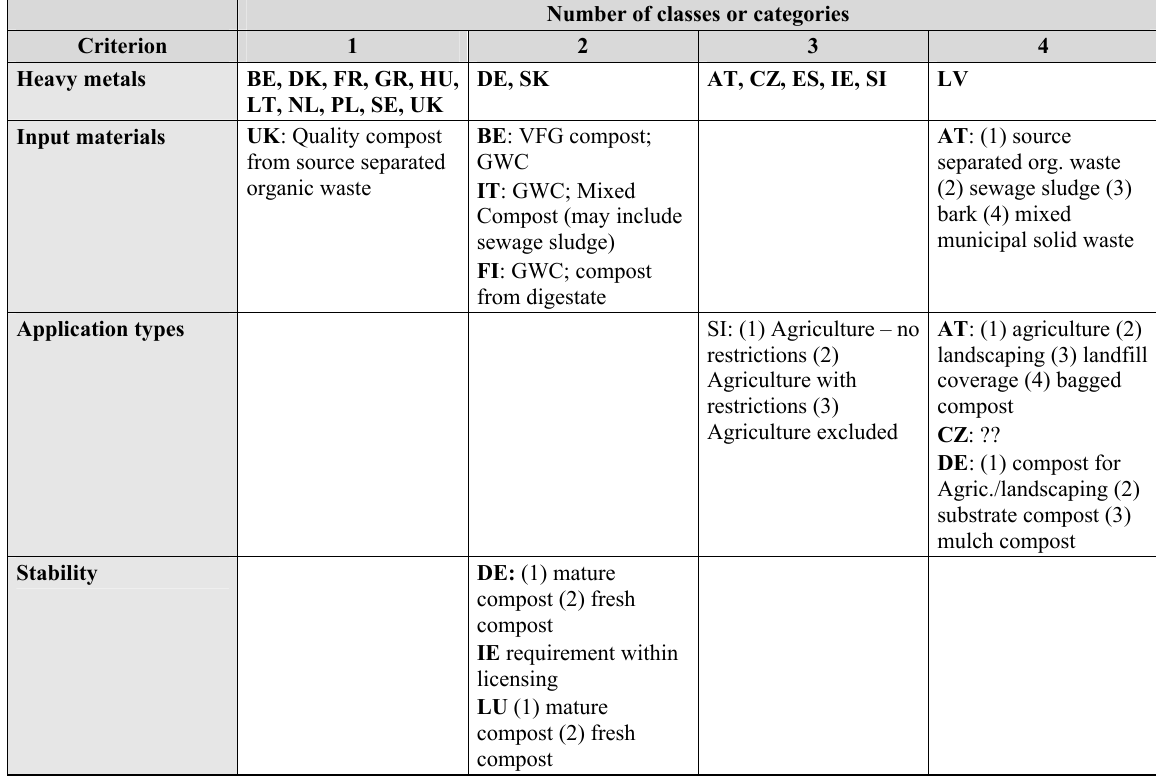
Summary table with compost classification types and number of classes adopted in national compost standards and